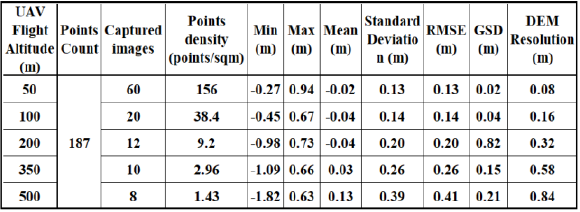
Table 1: Statistical results according to each flight altitude